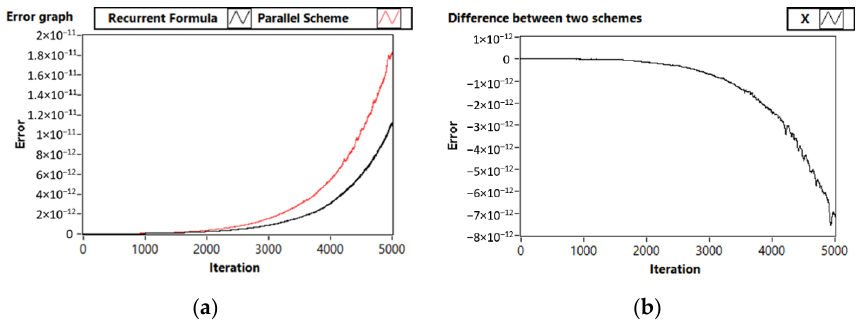
Figure 6. Absolute truncation error plots given relatively to the analytical solution for classical serial Runge–Kutta method and proposed parallel scheme ( a ). Difference between the truncation errors of parallel and serial solvers ( b ). Simulation time 5 s, step value 0.001 s.